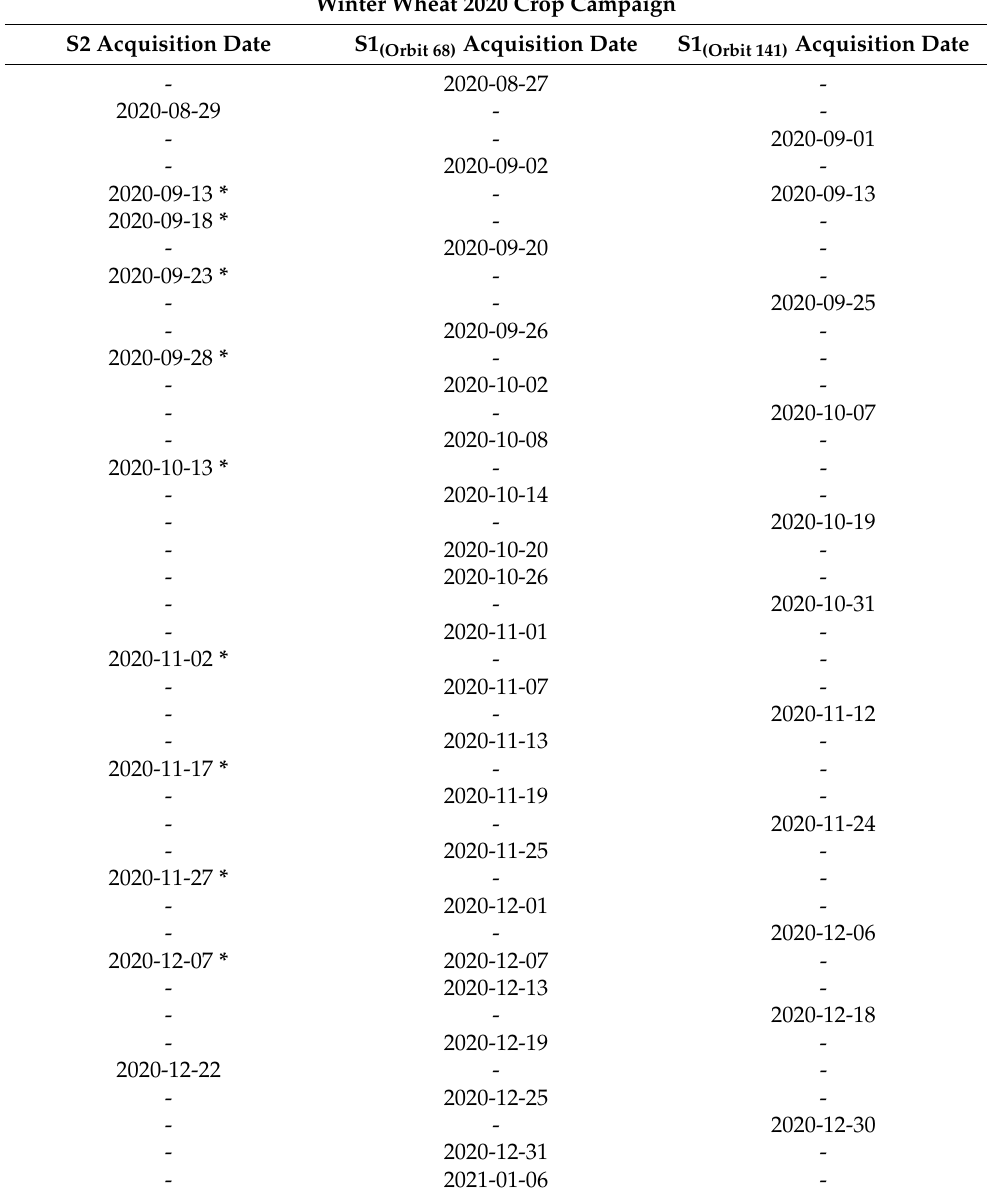
Table A1. Sentinel–2 and Sentinel–1 acquisition dates corresponding to the winter wheat 2020 crop campaign at the BVCR. The (–) symbol means no acquisition. The ( * ) indicates the S2 removed images from the S1 & S2 dataset for model